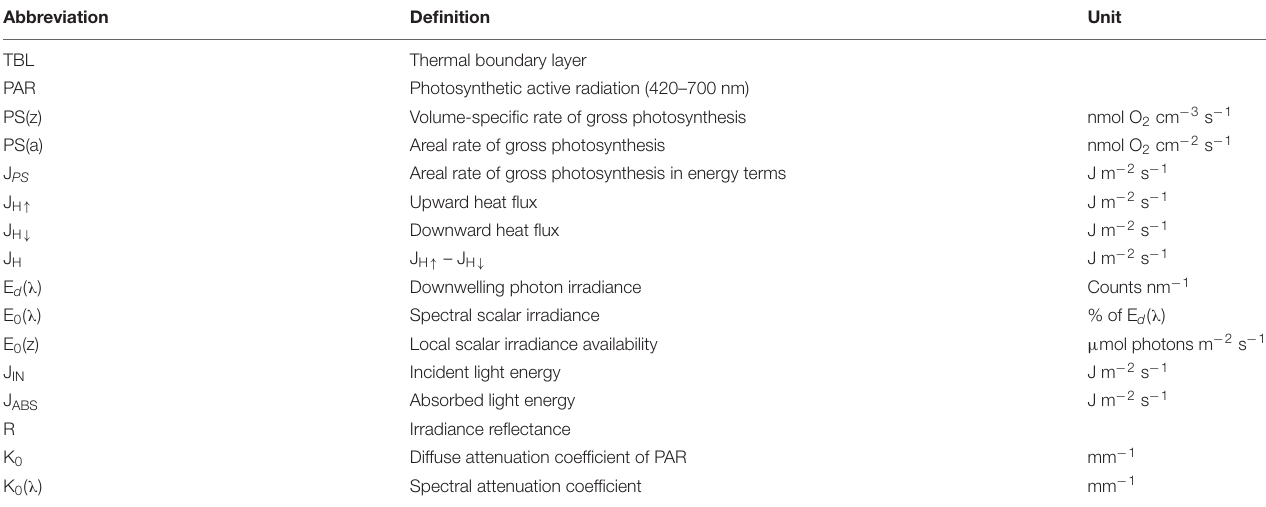
TABLE 1 | Definition of